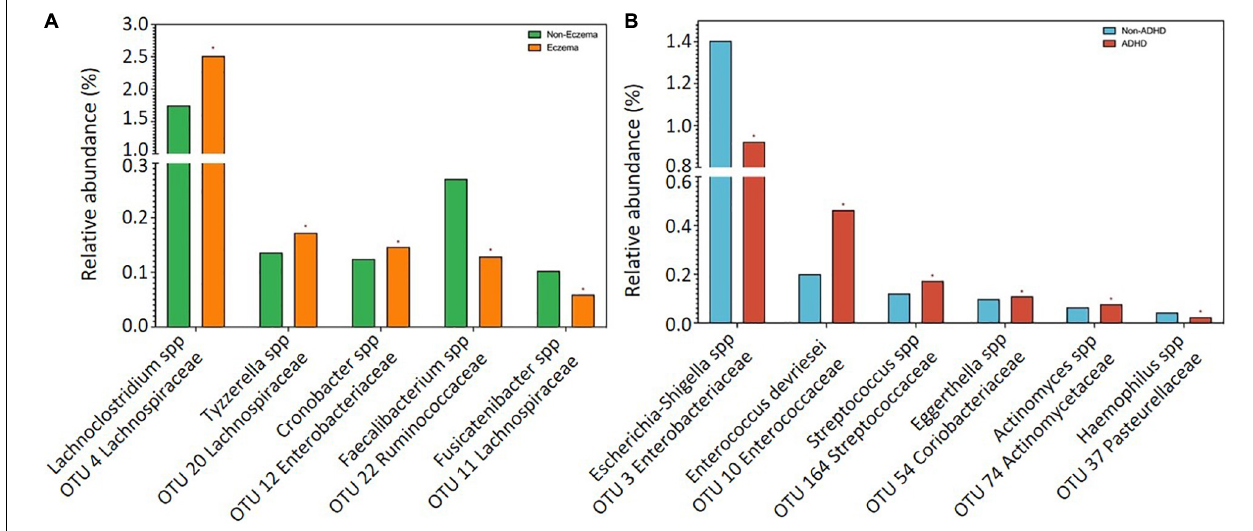
FIGURE 1 | Comparisons of bacterial candidates in gut microbiome at 24 months between children with and without (A) eczema by 18 months ( n = 72 vs 250), (B) ADHD symptoms at 54 months ( n = 65 vs 196). Data are presented as median. Only significant bacteria (adjusted p < 0.05) with reference to controls were shown.